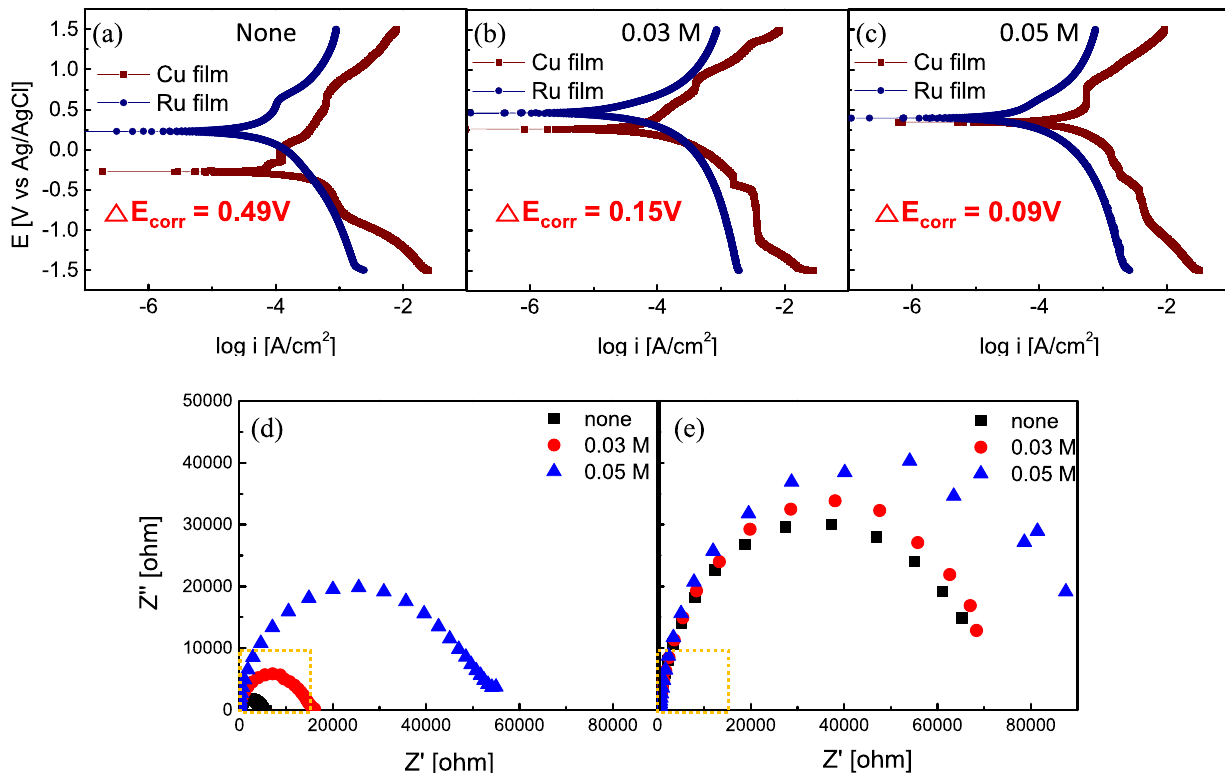
Figure 4. Electrochemical interaction evaluation between Cu/Ru films and nicotinic acid inhibitor. Potentiodynamic plots for Cu and Ru in solution as a function of inhibitor concentrations at pH 10 (a–c) : (a) w/o nicotinic acid, (b) 0.03 M nicotinic acid, and (c) 0.05 M nicotinic acid. Electrochemical impedance spectroscopy (EIS) data are showing Nyquist plots for (d) Cu film and (e) Ru film in solution for various inhibitor concentrations at pH 10.